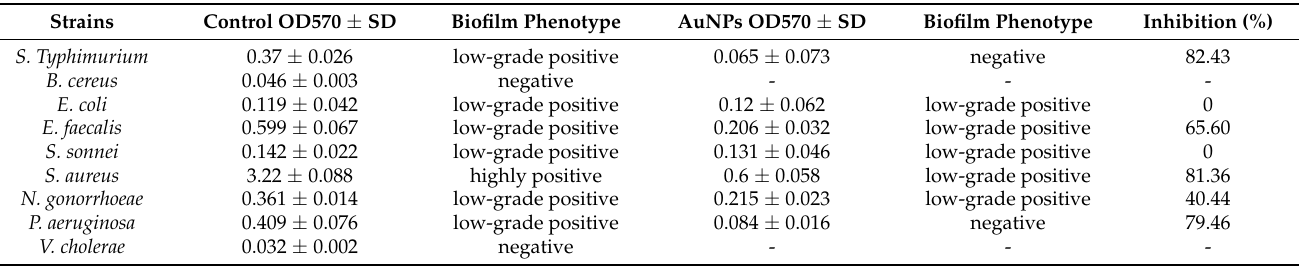
Table 1. Antibiofilm activity of AuNPs on